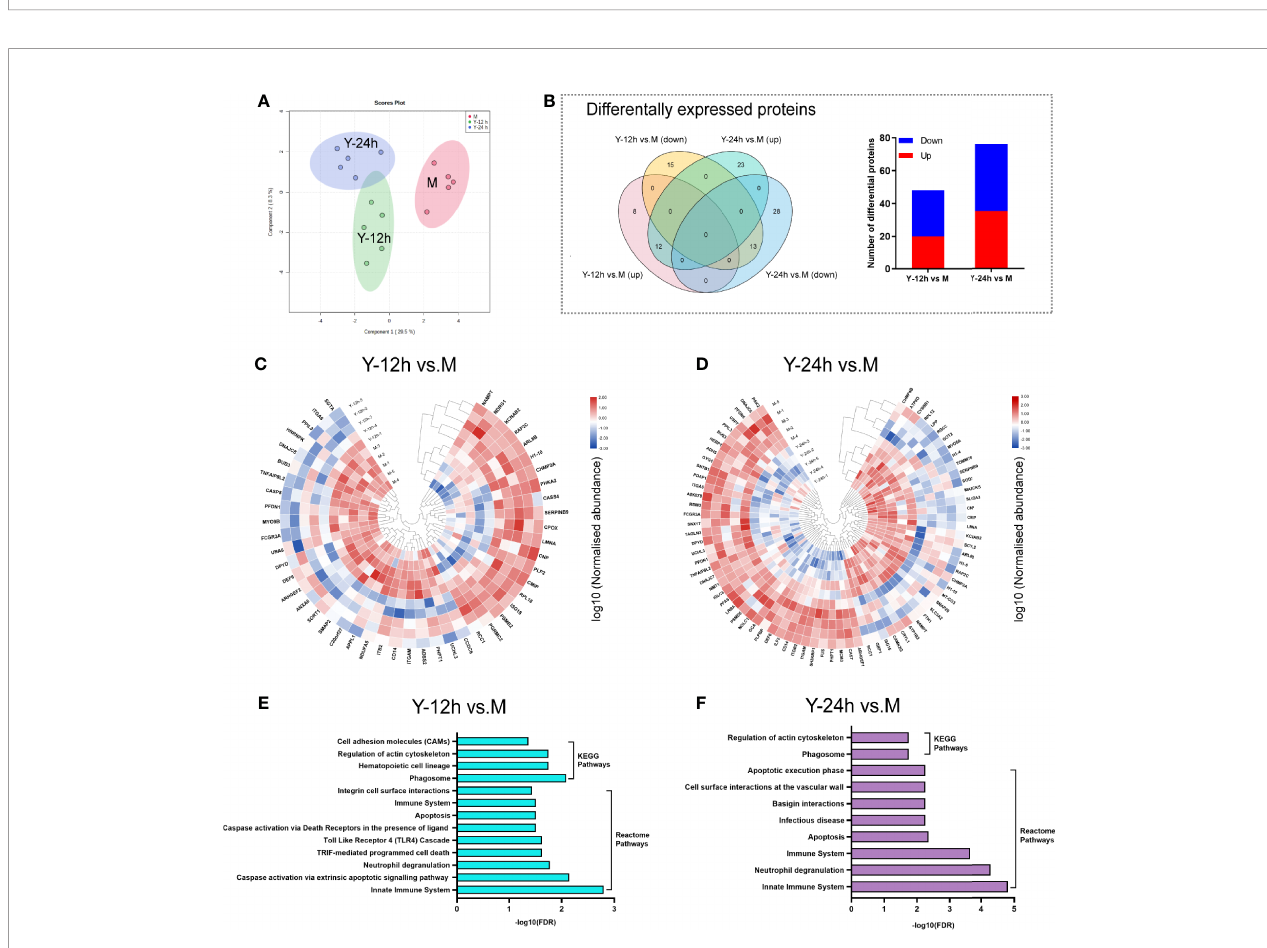
FIGURE 2 | Landscape of proteome analyses. (A) Principal component analysis (PCA) of unstimulated monocytes (M) and monocytes stimulated with heat-killed C. albicans for 12 h (Y-12 h) and 24 h (Y-24 h) (n = 5). (B) Proteins differentially expressed in monocytes after 12 h and 24 h stimulation by heat-killed C. albicans versus M group were displayed in Venn diagrams. Bar graph shows the number of up- (red) and down-regulated (blue) proteins. (C, D) Hierarchical clustering analysis of differential proteins between the Y-12 h or Y-24 h and M group with a P < 0.05 (Student ’ s t -test). Normalized abundances of proteins were logarithmic transformed. (E, F) Pathway analysis of the differentially expressed proteins in monocytes stimulated by heat-killed C. albicans metabolites that shifted from upregulated at 12 h to metabolome data. After stimulation with C. albicans , the Y-12 h downregulated at 24 h. Comparisons of Y-12 h versus M and Y- versus M and Y-24 h versus M comparisons shared 65 changed 24 h versus M individually showed 84 (68 upregulated and 16 metabolites, including 52 upregulated and 11 downregulated, and downregulated) and 227 (183 upregulated and 44 downregulated) the overlap between the two time points contained two